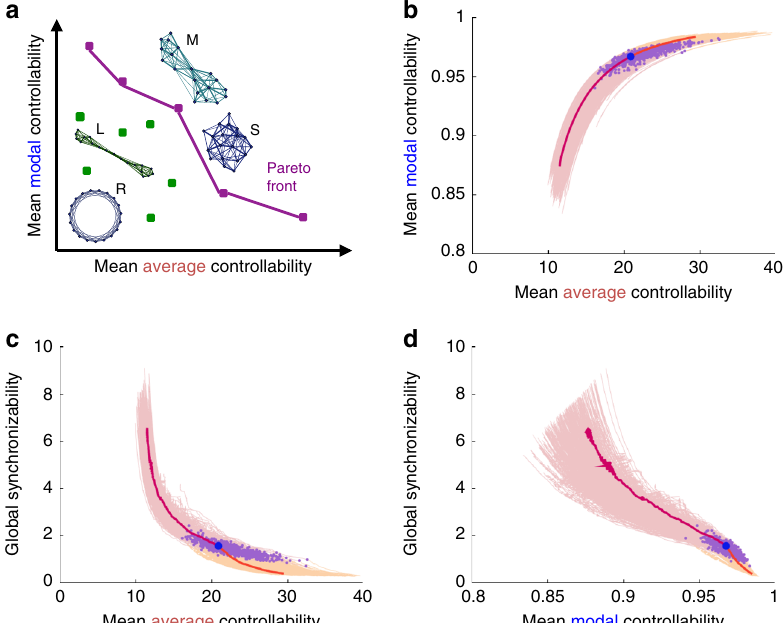
Fig. 4 Brain networks are optimized for diverse dynamics. a Pareto optimization explores a family of networks with different topologies and hence varying mean controllability and synchronizability (a few toy models illustrate this including a ring lattice R, regular lattice L, modular network M, and small-world network S). Pareto-optimal networks (purple dots) are the networks where these properties are most ef fi ciently distributed, i.e., it is impossible to increase one property without decreasing another property — unlike in the non-optimal networks (green dots). The boundary connecting the Pareto-optimal networks forms the Pareto front (purple line). b – d Beginning from an empirically measured brain network (purple dots), we swap edges to modify the topology and test if the modi fi ed network advances the Pareto front. This procedure charts a course of network evolution characterized by increasingly optimal features: here we increase mean average controllability and mean modal controllability, and decrease global synchronizability, in 1500 edge swaps (yellow curves). For comparison, we also evolved the network in the opposite direction (to decrease controllability and increase synchronzability, pink curves). The trajectory for one subject (blue dot) is highlighted (orange and red). See Methods section for evidence of convergence of controllability metrics in the forward direction after 1500 edge